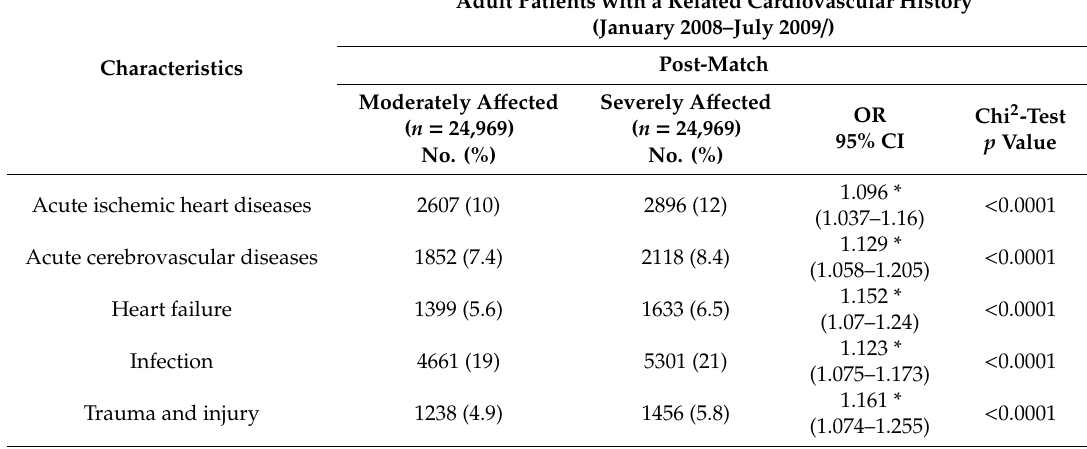
Table 3. Hospitalizations after Typhoon Morakot in a ff ected adults with preexisting histories of cardiovascular and cerebrovascular diseases before Typhoon Morakot.